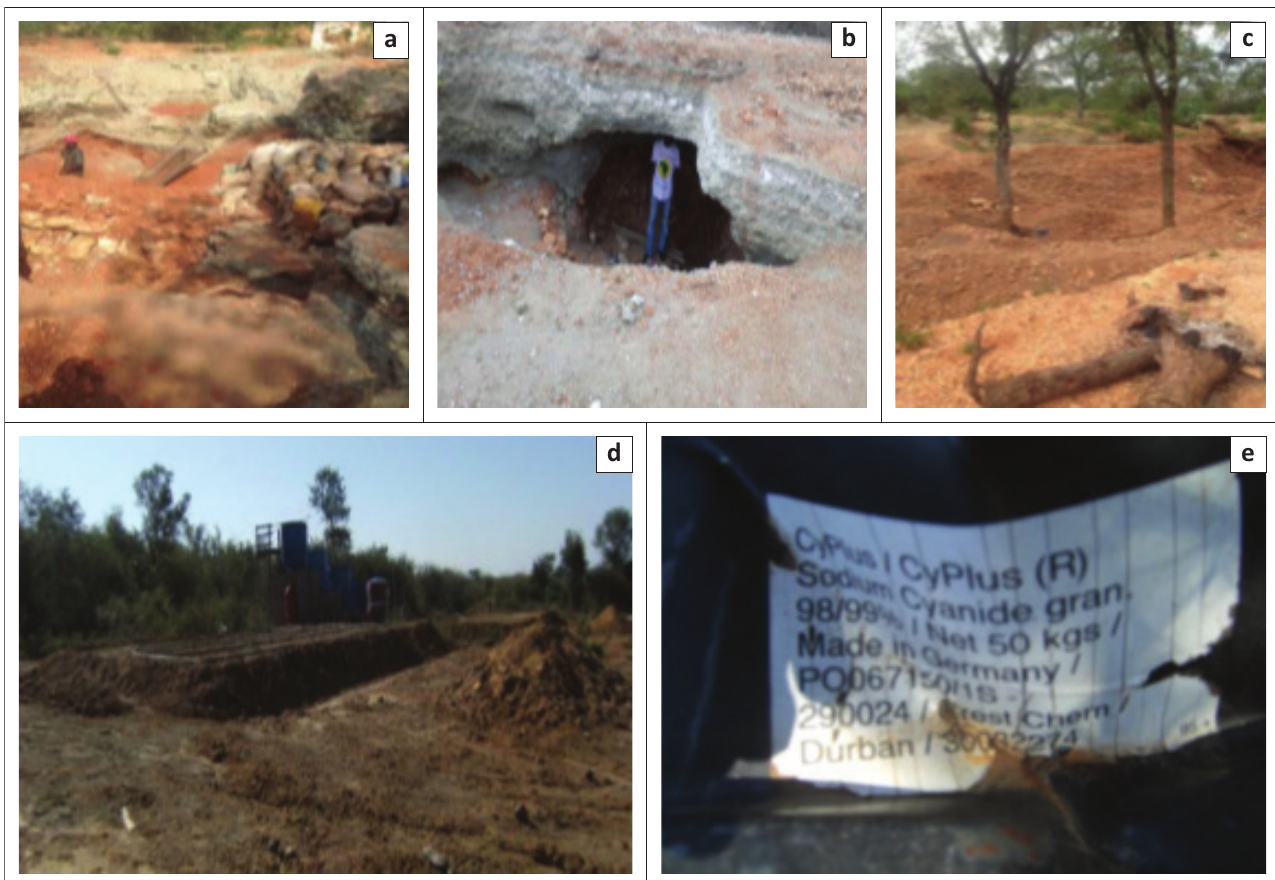
FIGURE 2: Artisanal mining at the Sutherland goldfield: (a) Fine gravel digging operations, (b) hazardous excavation at Louis Moore Mine, (c) the impact of excavations on trees around New Union Mine, (d) an abandoned cyanide heap leaching setup (e) and an empty container of the leaching chemical